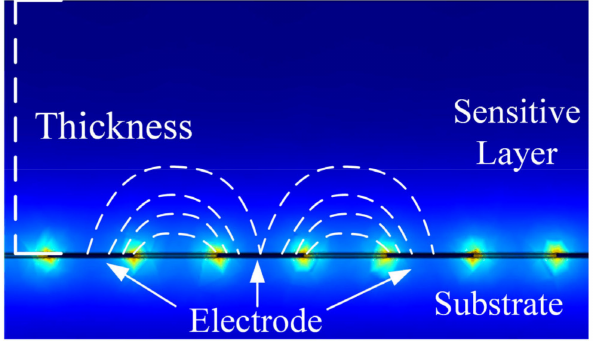
Figure 3. Simulation model of the IDE capacitive humidity sensor.